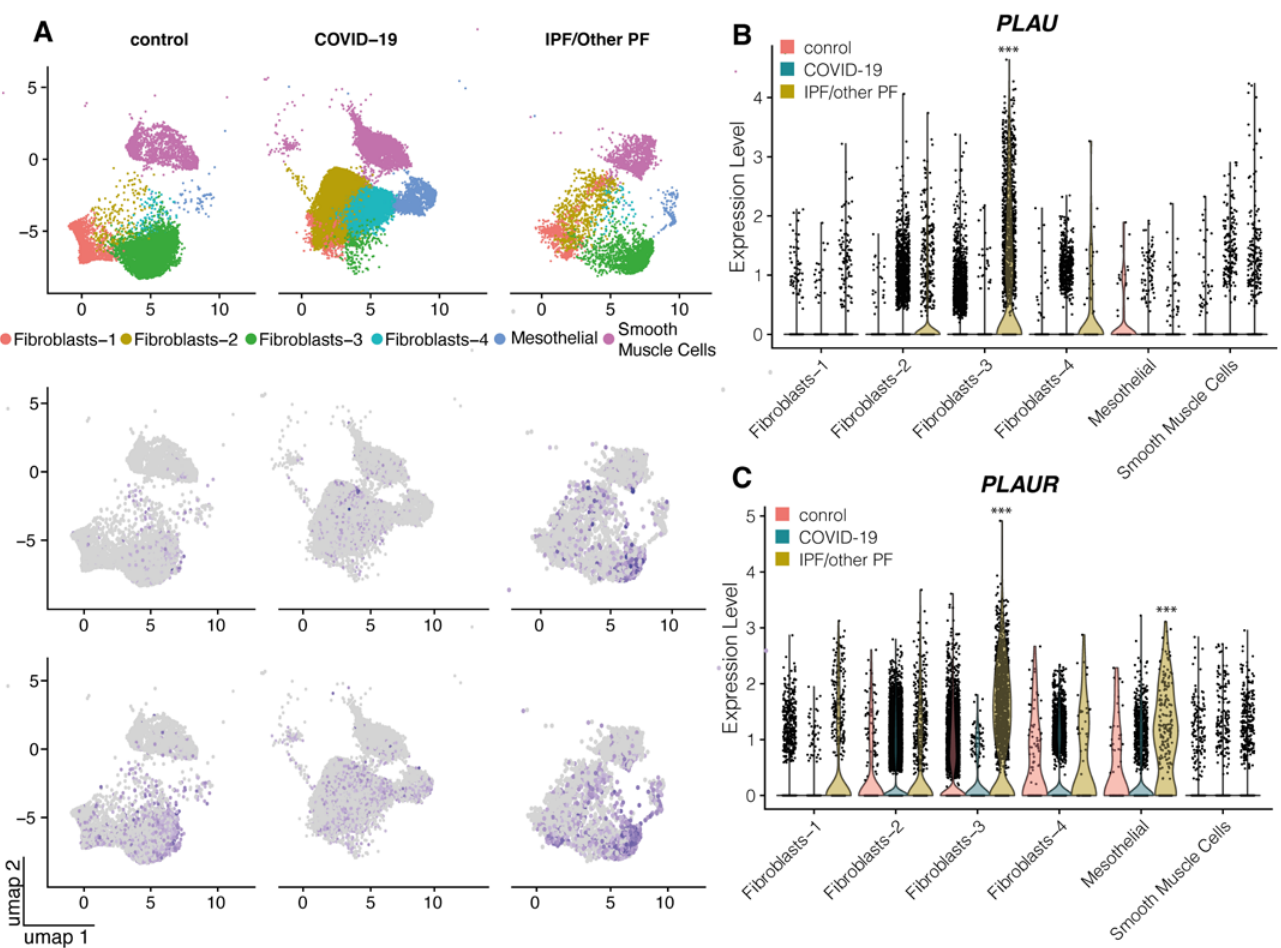
Figure 2. PLAU and PLAUR expression in the mesenchymal cells of control, COVID-19 and PF lung samples: ( A ) UMAP embedding of jointly analyzed single-cell transcriptomes annotated by cell type (color) and disease status. Lung tissue transcriptomes of patients with COVID-19-associated pneumonia, pulmonary fibrosis (PF) and control lung samples from healthy donors, reported in Haber- mann et al. and Bharat et al. (GSE158127, GSE135893 [35,36]), were analyzed. Normalized expression levels of PLAU ( B ) and PLAUR (C) in different cell types of mesenchymal cells; statistics were calcu- lated only for the cell types with the median normalized expression value > 0. *** p adjusted < 0.0001 as assessed by FDR. IPF/other PF, idiopathic pulmonary fibrosis and other pulmonary fibrosis; umap, Uniform Manifold Approximation and